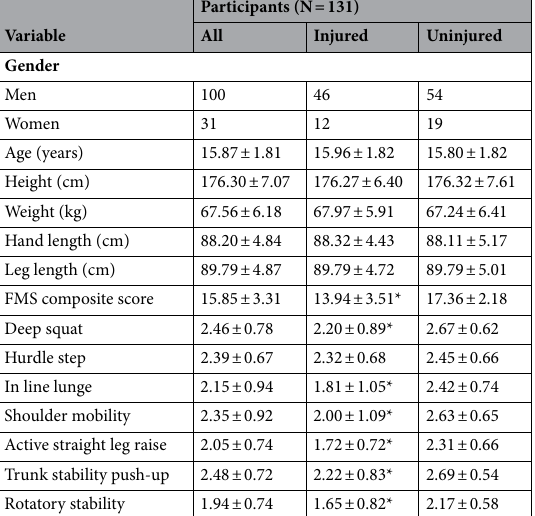
Table 1. Demographic and baseline characteristics of participants. *The mean differences are significant comparing to the un-injured participants at the p < 0.05